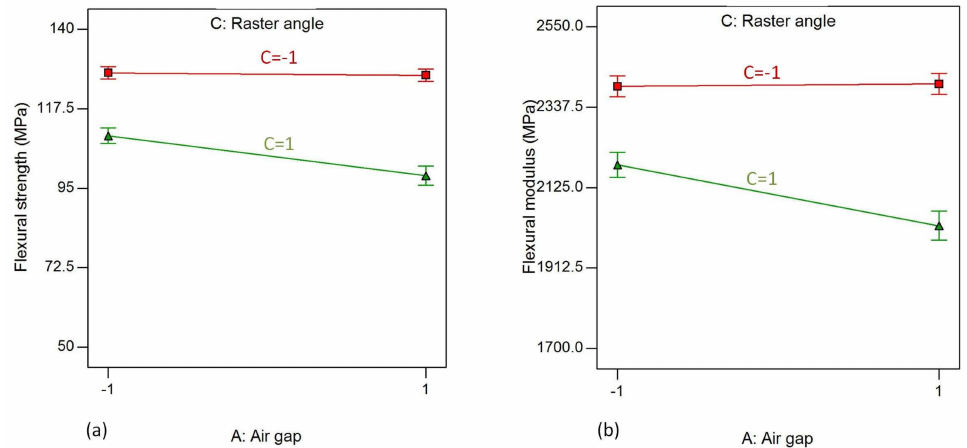
Figure 15. Interaction effect of air gap and raster angle on ( a ) flexural strength and ( b ) flexural modulus, while raster width, contour number and contour width are kept at their highest level.